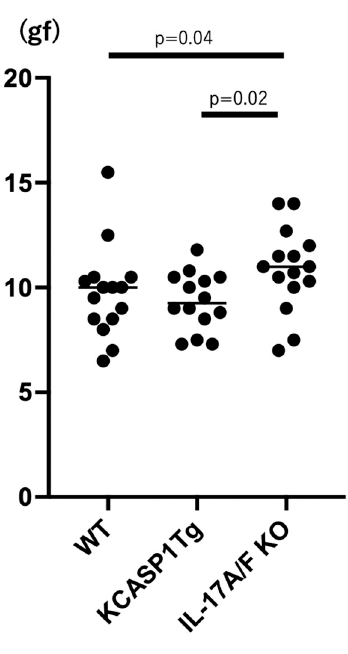
Figure 6. Snapping tension in the abdominal aorta. KCASP1Tg mice showed fragility compared to WT mice. A deficiency of IL-17A/F showed rather enhanced vascular firmness and elasticity compared to WT littermates. N = 15, for each group. The statistical analysis was performed with the Ordinary one-way ANOVA followed by Tukey’s multiple comparison test.